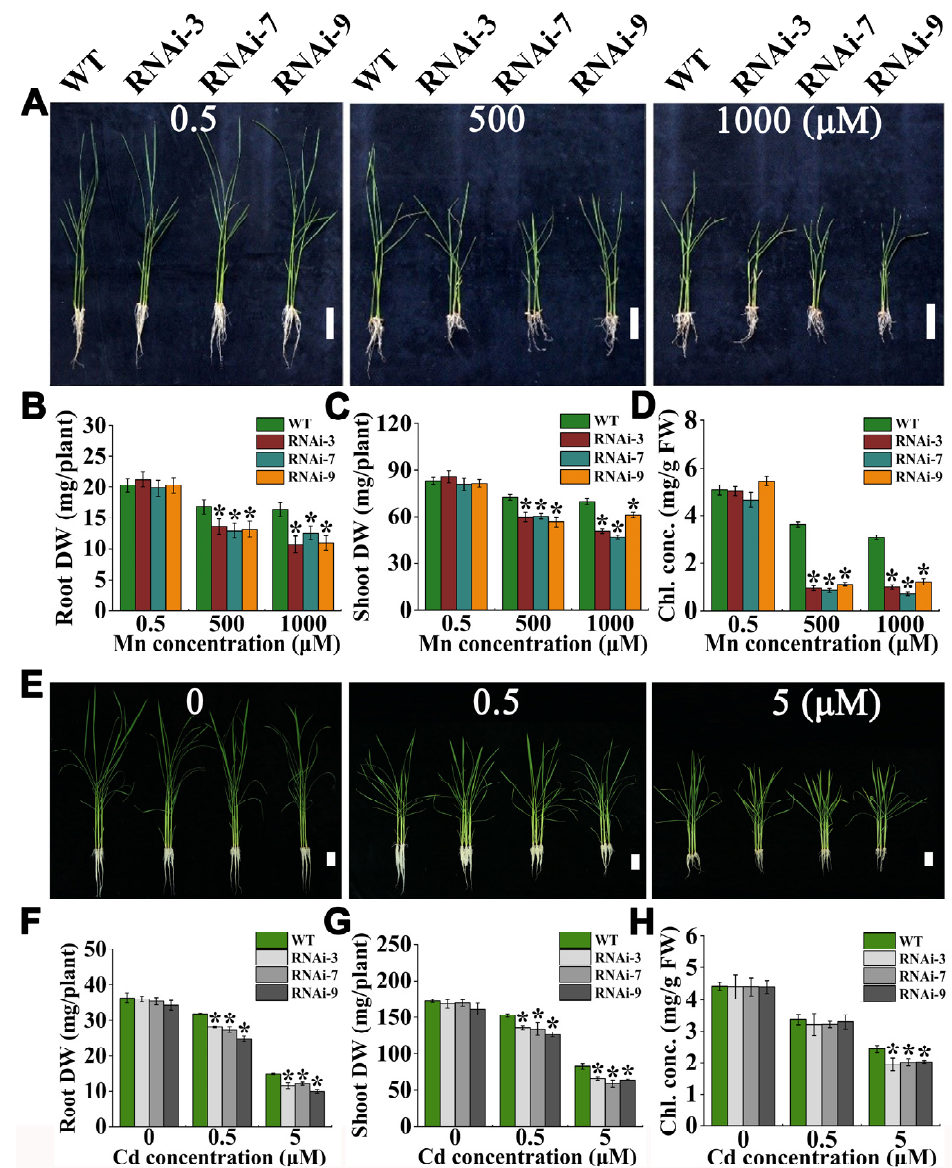
Figure 3. Growth responses of WT and RNAi lines to excessive Mn and Cd stress. Two week-old young rice plants were grown in nutrient solution supplemented with Mn (0.5, 500, and 1000 µ M) and Cd (0, 0.5, and 5 µ M) for 14 days. ( A – D ) Mn stress. ( E – H ) Cd stress. ( A , E ) Phenotypes of WT and RNAi lines. Bars = 5 cm. Comparative growth responses between WT and RNAi lines under Mn and Cd stress, as presented by root dry weight (DW) ( B , F ), shoot DW ( C , G ), total chlorophyll concentration ( D , H ). FW, fresh weight. Error bars indicate the means ± standard deviations of three biological replicates. Asterisks indicate that the mean values of three replicates are significantly different between WT and RNAi lines ( p < 0.05).